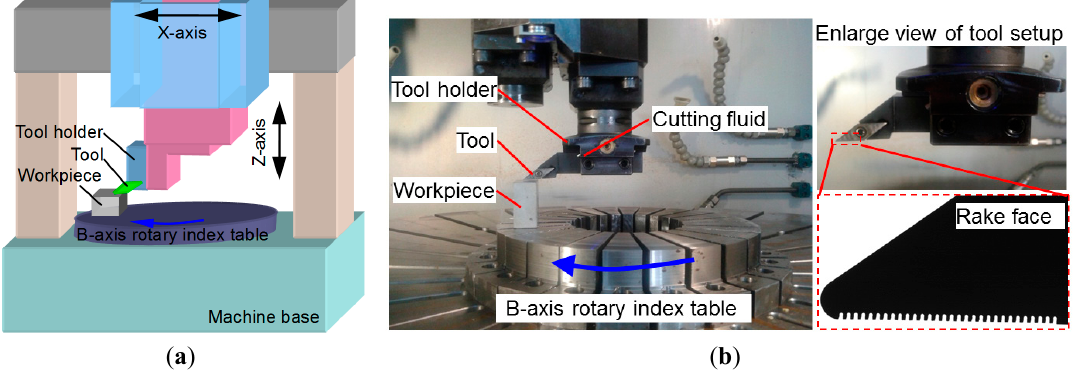
Figure 3. ( a ) Illustration and ( b ) picture of experimental setup for micro structure fabrication in turning process.